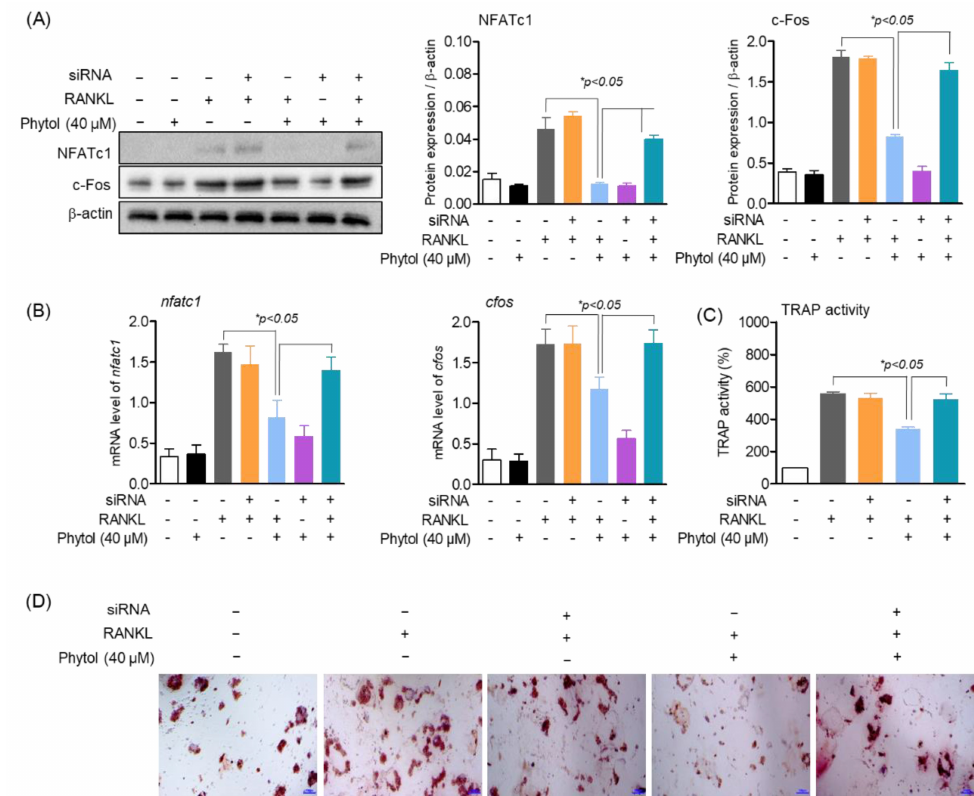
Figure 7. Inhibition of osteoclast differentiation and function by phytol is regulated through Nrf2. ( A ) NFATc1 and c − Fos protein expression were measured by Western blot analysis and normalized to that of β -actin. ( B ) nfatc1 and cfos mRNA expression were detected by RT − PCR. ( C , D ) Cells (1 × 10 3 cells/well) were treated with phytol in the presence of RANKL with or without Nrf2 silencing using siRNA. After 5 days incubation, the cells were assessed for multinucleated osteoclast differentiation using TRAP activity and stained. Data are presented as the mean of three independent experiments (Mean ±